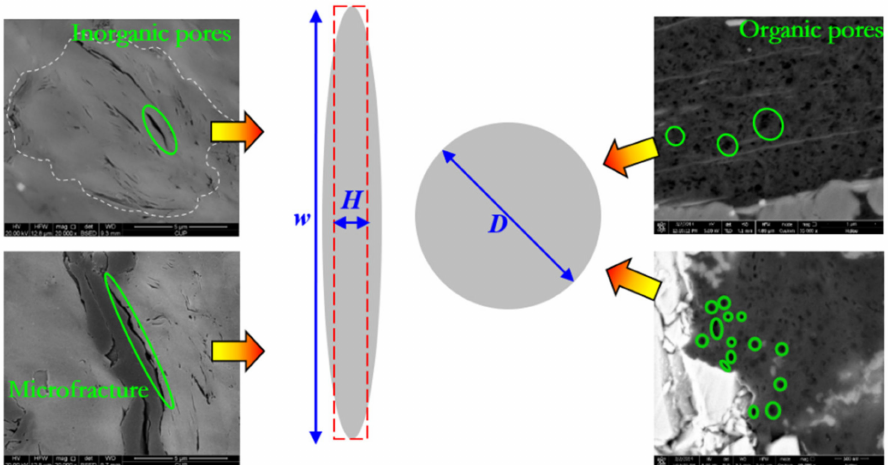
Figure 2. Structures of nanopores and fractures in shale. (Orange arrows mean that the shale nanopores can be simplified as slit pores or circular